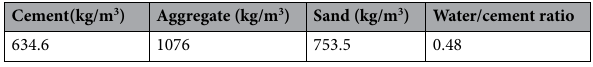
Table 1. Existing mix design.